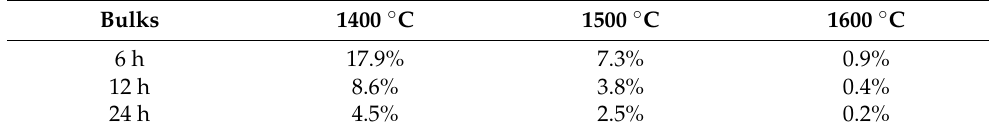
Table 3. The sintered bulks’ porosities analyzed through image